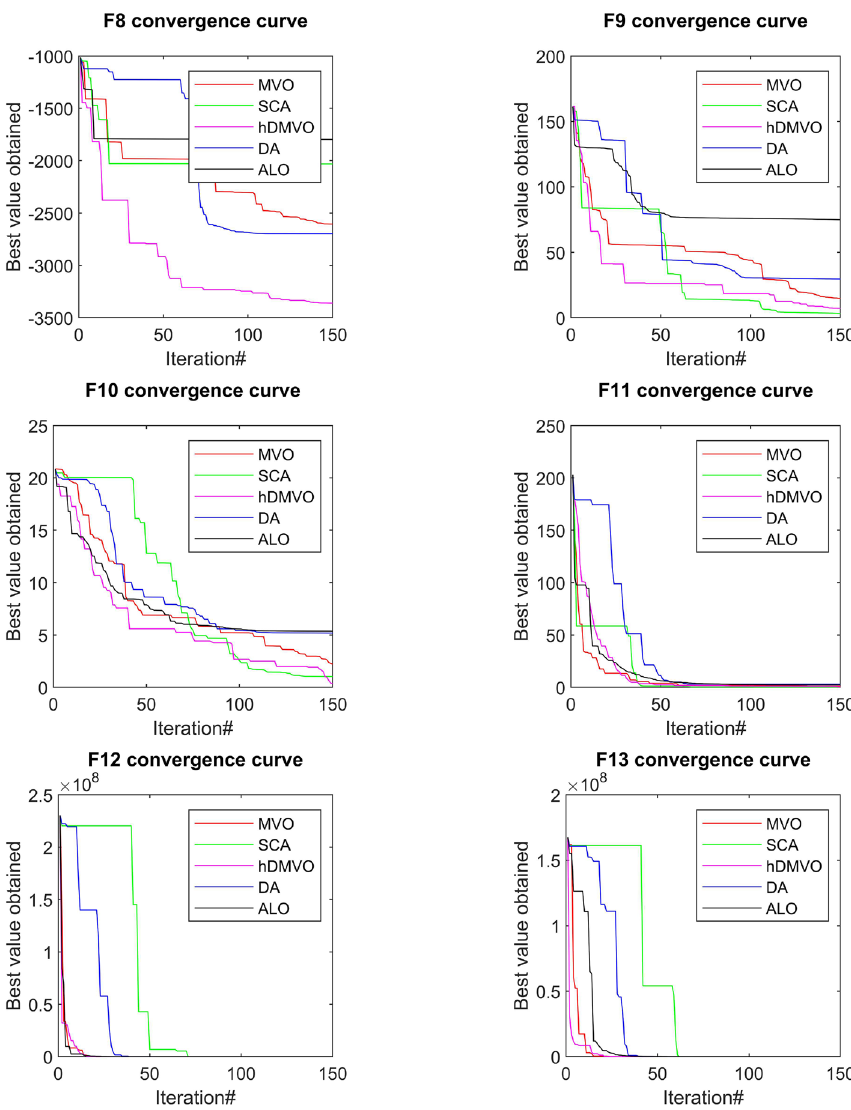
Figure 8. Convergence curves of MVO, SCA, ALO, DA, and hDMVO variants for multimodal